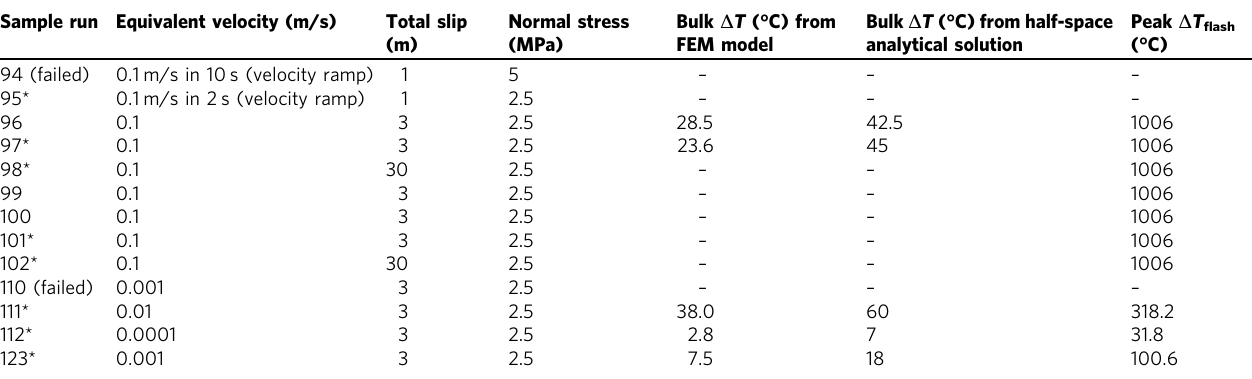
Table 1 Summary of friction experiments and calculated temperature rise from FEM model Sample run Equivalent velocity (m/s)